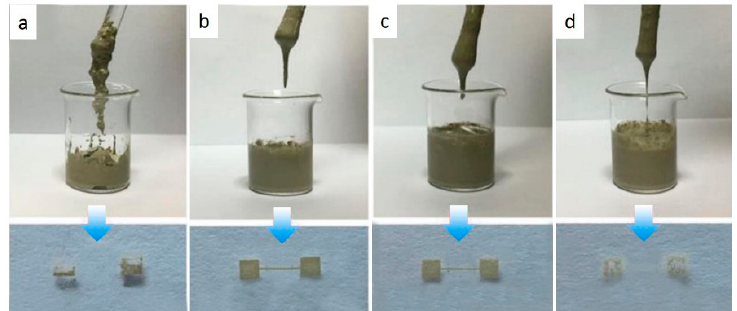
Figure 3. Images of the AgNWs ink and the corresponding screen-printed lines (Top: AgNW-inks. Bottom: screen-printed Ag NW lines.) with the water content x of ( a ) 1.0, ( b ) 1.5, ( c ) 1.8, ( d ) 2.0 g (AgNWs:cellulose:water = 0.4:0.4: x ). Reprinted with permission from [35]; Copyright 2019 Wiley-VCH Verlag GmbH & Co. KGaA.